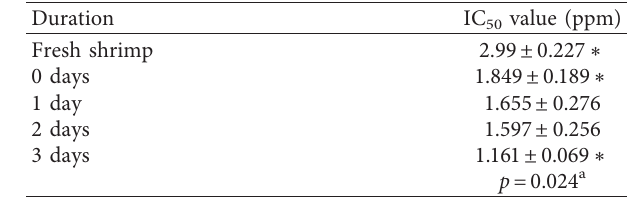
Table 1: Results of the inhibition percentage (%) of fermented shrimp sausages at different fermentation times.